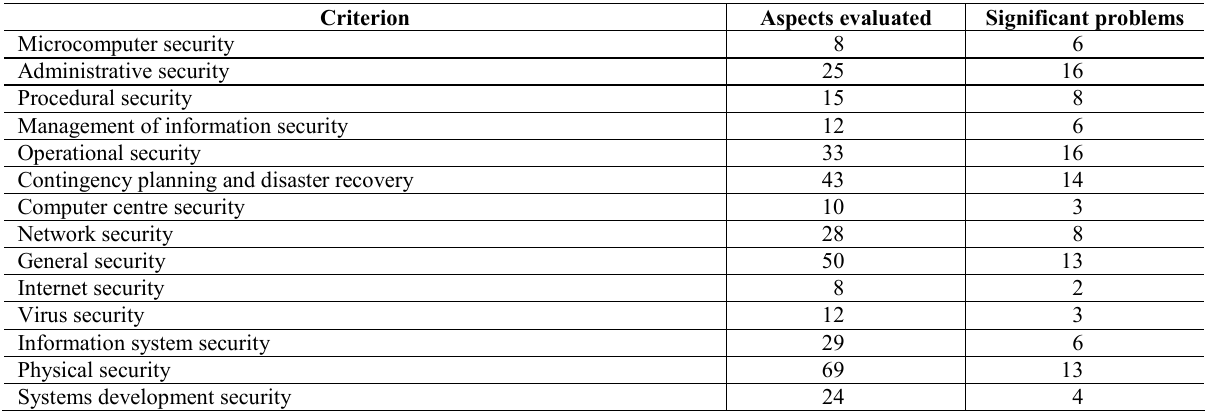
Table 3: Evaluation of information security according to fourteen key areas